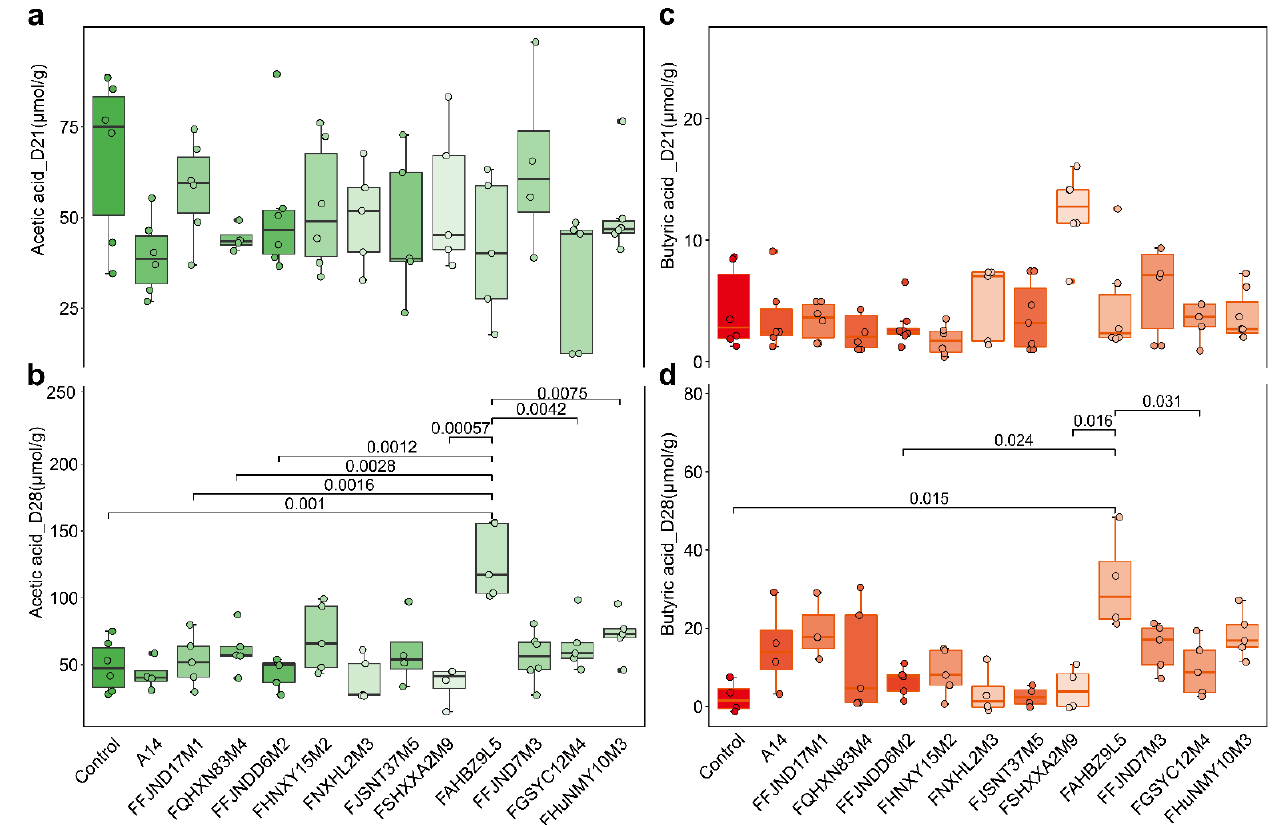
Figure 10. Relative abundance of short chain fatty acids (SCFA) in fecal microbiota among different mice groups at different time points (( a , c ): 21 days; ( b , d ): 28 days). Green represents the acetic acid and red representing the butyric acid. The t -test p -values show that this variation was statistically significant ( t -test p < 0.05).